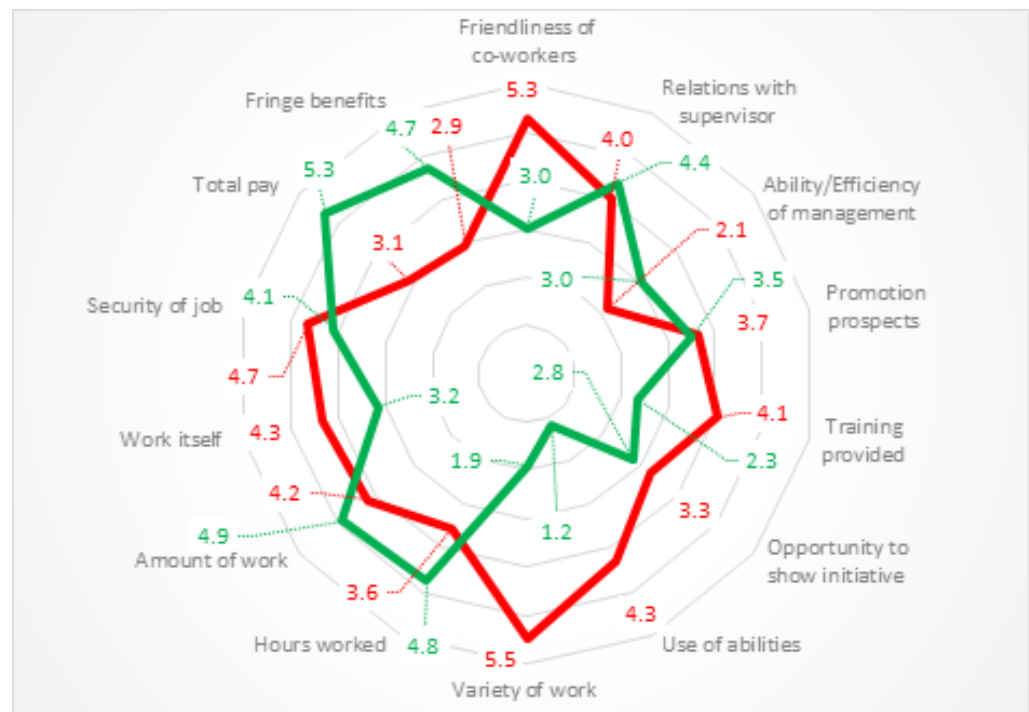
Figure 2. Employee job satisfaction (red line) compared to perceived importance of motivation (green line) (1–7-point scale).